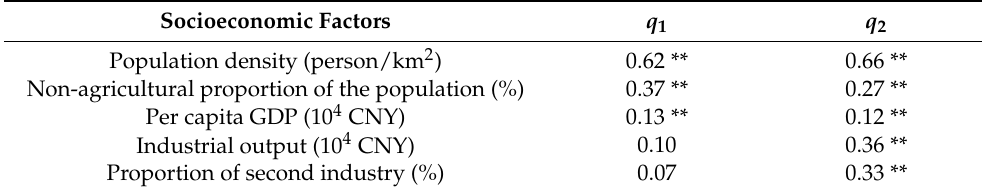
Table 2. The q values ( q 1 , q 2 ) for the association between PM 2.5 concentrations and socioeconomic factors in Northern and Southern China, respectively.